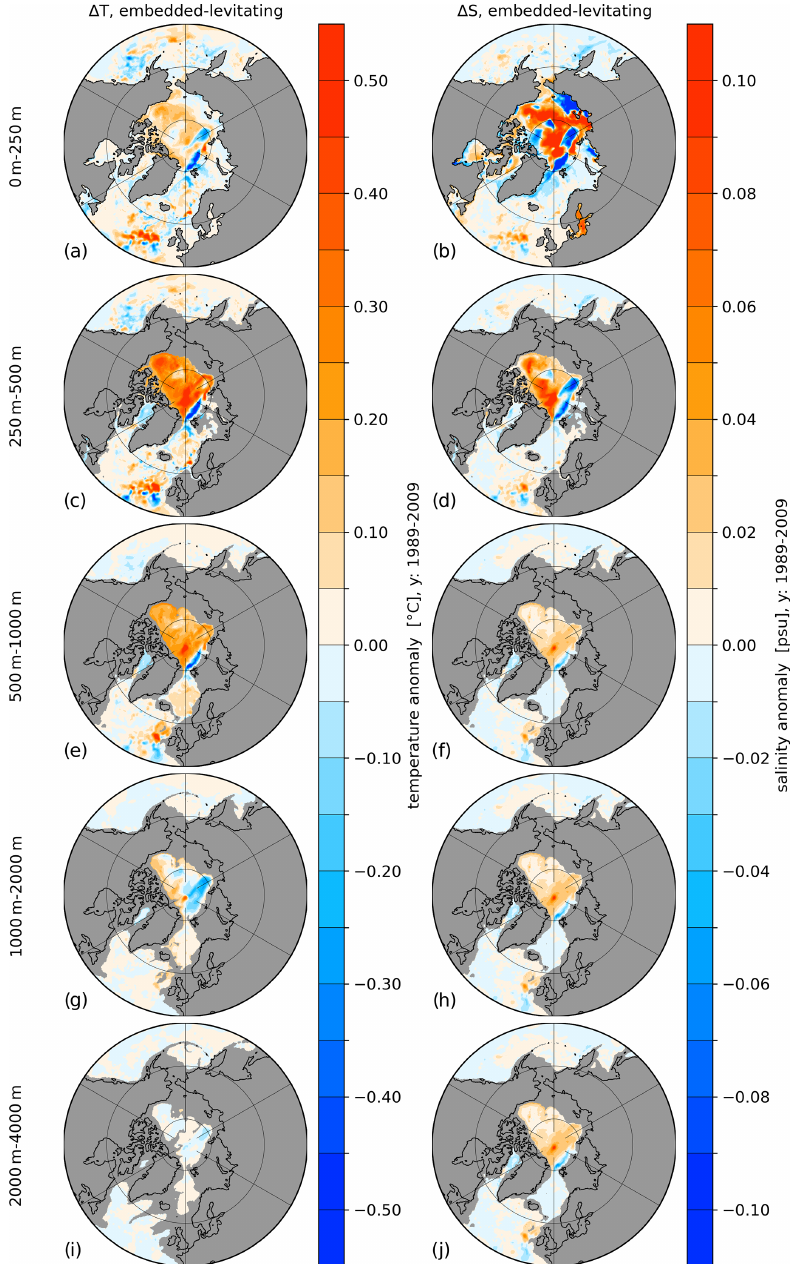
Figure 7. Temperature ( a, c, e, g, i ) and salinity ( b, d, f, h, j ) difference between embedded and levitating sea ice averaged for the period 1989 to 2009. Panels show, from top to bottom, the vertically averaged fields for the depth ranges of 0–250, 250–500, 500–1000, 1000–2000 and